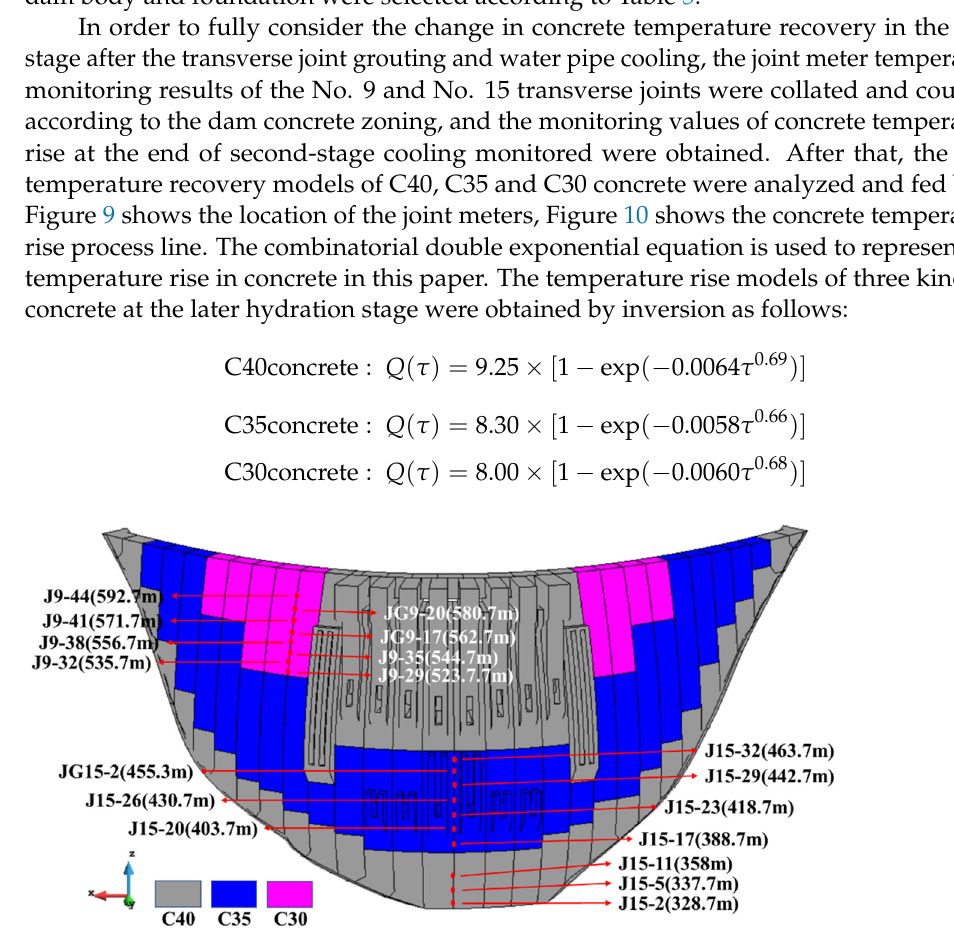
Table 5. Thermal parameters of dam body and foundation.